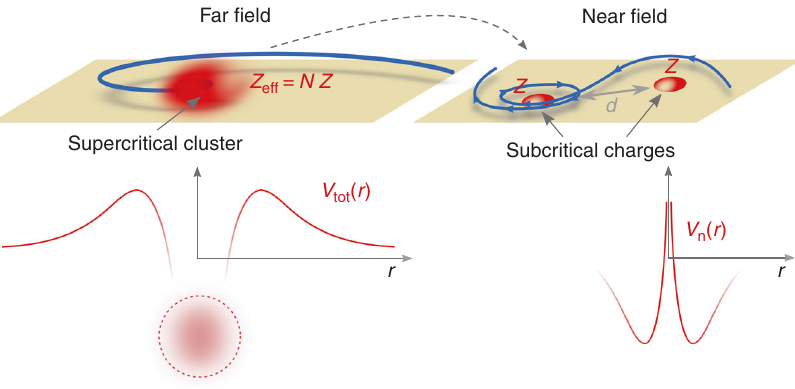
Fig. 5 Far- fi eld vs. near- fi eld semiclassical trajectories for frustrated supercriticality: The far- fi eld potential V tot ( r ) of a supercritical cluster (left) induces collapse because N Z > Z C . Orbits here describe a collapsing spiral toward the charge cluster. In the near- fi eld, on the other hand, each individual potential V n ( r ) is subcritical (right) and the orbits approach the charges without falling into them. The supercritical collapse is thus frustrated by the subcritical individual charges in the near- fi eld. This is analogous to light rays gravitationally trapped by a dense cluster of stars (Supplementary Note